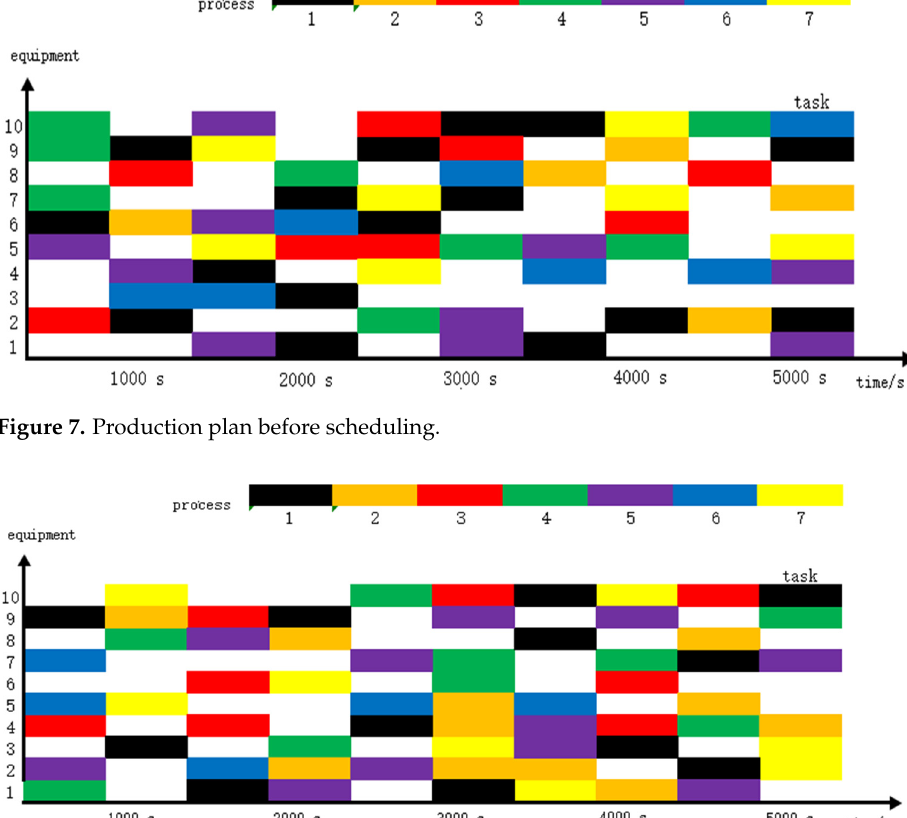
Figure 8. Scheduling scheme for complete human cooperation.